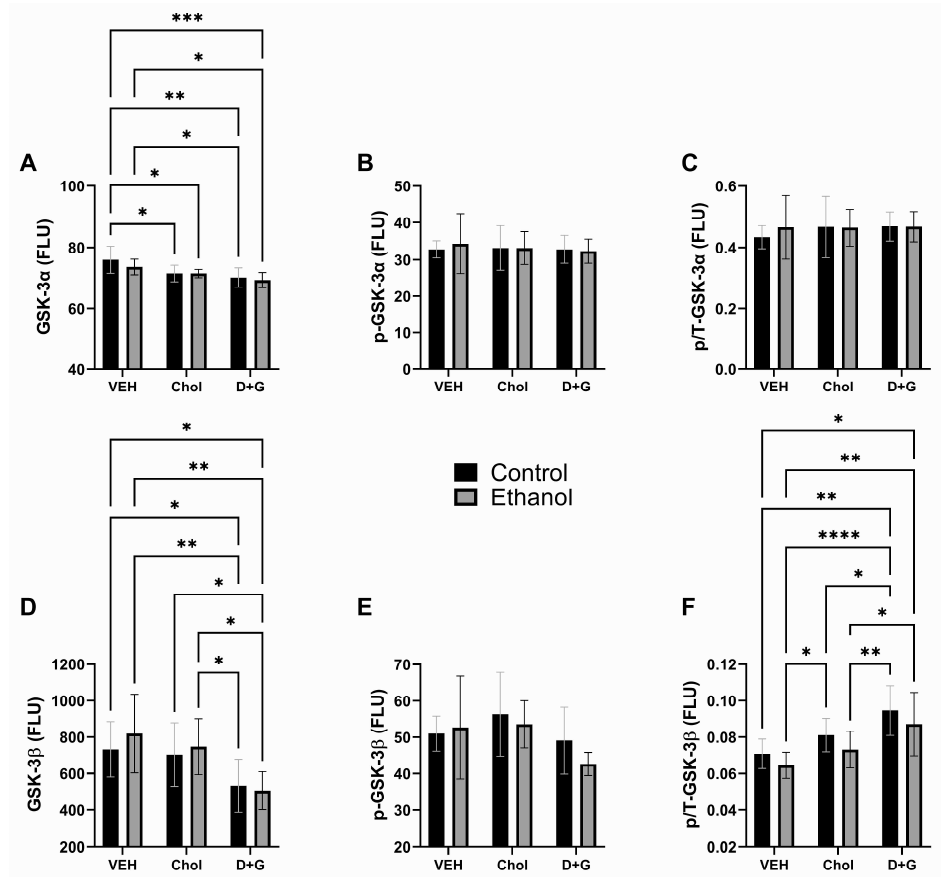
Figure 5. Ethanol and treatment ( Chol and D+G) effects on intermediate key signaling molecules in the Insulin/IGF-1-Akt-mTOR pathway. ( A ) GSK-3 α , ( B ) pS21 -GSK-3 α , ( C ) p/T-GSK-3 α , ( D ) GSK-3 β , ( E ) pS9 -GSK-3 β , and ( F ) p/T-GSK-3 β . Graphs depict the mean ± SD of immunoreactivity (N = 6 cultures/group; FLU = fluorescent light units). Inter-group differences were analyzed by two-way ANOVA (see Table 3) with post-hoc Tukey tests. * p < 0.05; ** p < 0.01; *** p < 0.001; **** p < 0.0001. GSK-3 β : Ethanol had a statistical trend effect on p/T-GSK-3 β . Treatment (Chol or D+G) had significant effects on GSK-3 β protein and p/T-GSK-3 β , and a trend effect on pS9 -